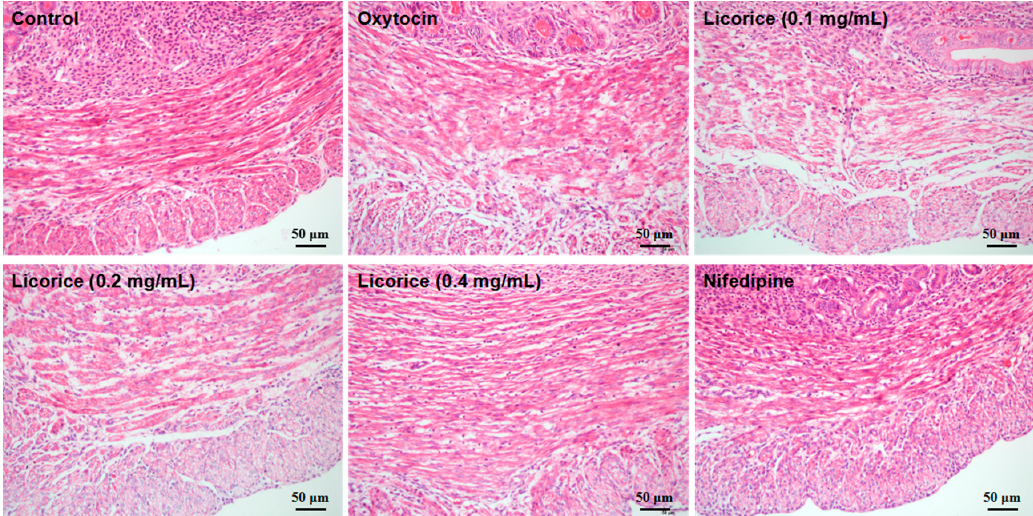
Figure 3. Effects of licorice aqueous extract on morphological changes in the uterine inner annular layer. Example histological section of the uterine inner annular layer using HE staining under the light microscope at 200× objective. No discernible pathological changes were observed in the control group and the myometrial cells were slender with round nuclei, which was described as fusiform nucleated cells. The short rod-shaped cells with shorter nuclei were in contractile status, which was described as oval nucleated cells. The licorice aqueous extract downregulated the proportion of oval nucleated cells (contractile cells) in uterine inner annular layer.